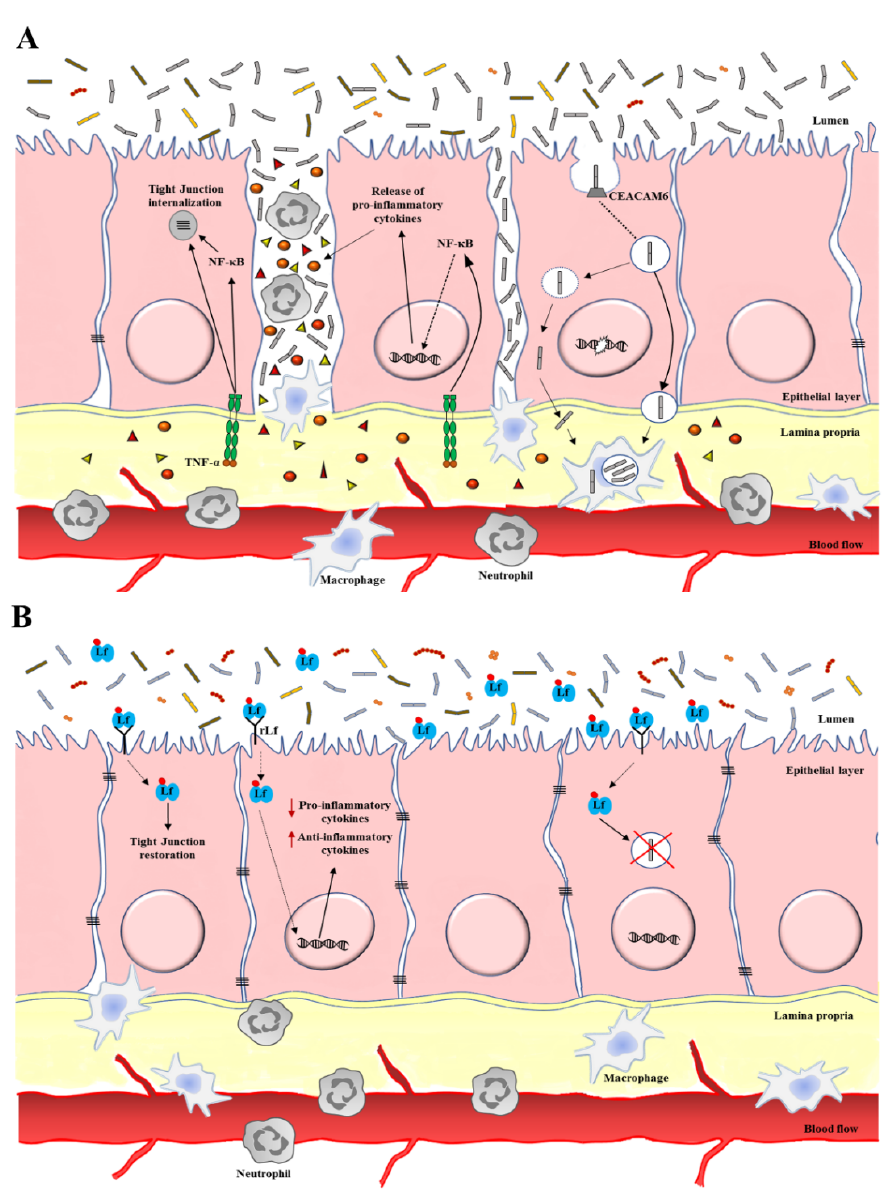
Figure 2. Schematic representation of the role of lactoferrin (Lf) in rebalancing tissue homeostasis in intestinal epithelium a ff ected by an inflammatory bowel disease (IBD). ( A ) In IBD, the intestinal epithelium barrier dysfunction is related to destructive inflammatory stimuli, which, in turn, promote microbial dysbiosis. In this scenario, the intestinal epithelium participates in the recruitment of immune cells through cytokine / chemokine release, mainly mediated by TNF- α and NF-kB pathways, which are also responsible of tight junctions (TJs) internalization. The increased epithelium permeability facilitates cell adhesion and invasion by facultative intracellular pathogens, i.e., AIEC LF82, able to replicate in both enterocytes and macrophages, and to damage cell defense by inducing host DNA damage. ( B ) E ff ect of Lf treatment on intestinal epithelium. Lf can act as a multi-targeting agent, able to: (i) counteract microbial dysbiosis through its bacteriostatic and bactericidal activities, as well as by interfering with adhesion, invasion and survival of facultative intracellular pathogens; (ii) rebalance immune homeostasis through its ability to modulate / boost immune system and correcting inflammatory imbalance; (iii) restore intestinal barrier integrity by favoring TJs up-regulation and membrane localization. Orange circles and red / yellow triangles represent pro-inflammatory cytokines; red dots attached to Lf represent ferric ions.